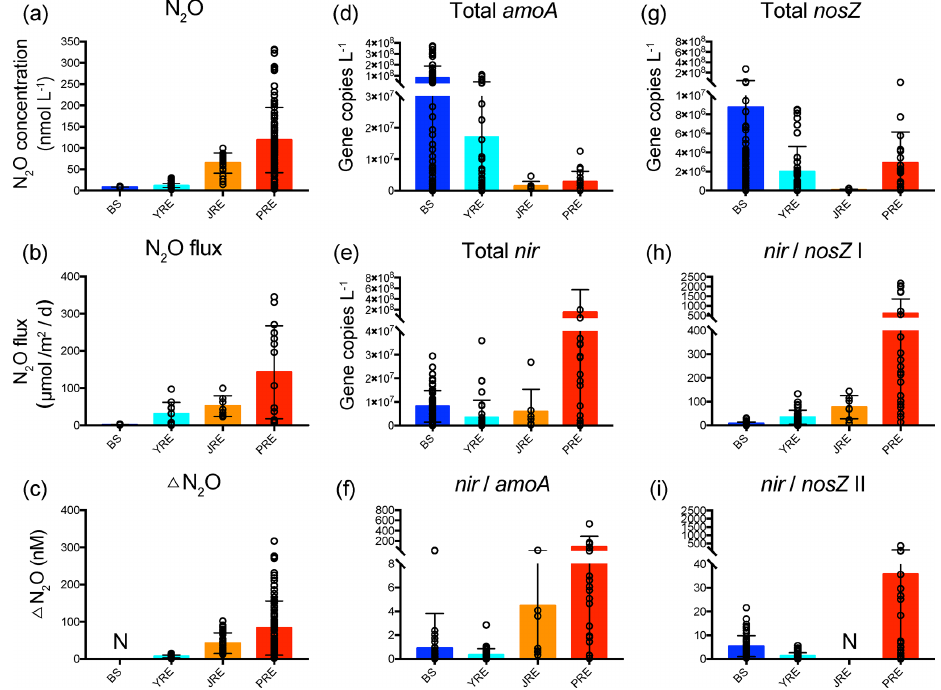
Figure 6. The ranges of (a) N 2 O concentration; (b) N 2 O flux; (c) (cid:49) N 2 O (data from Chen et al., 2008; Lin et al., 2016, 2020; Ma et al., 2019; Song et al., 2015; Wang et al., 2014, 2016; Wu et al., 2013; Xu et al., 2005; Zhan et al., 2011; Zhang et al., 2008, 2010); (d) total archaeal and bacterial amoA gene abundance; (e) total nirS and nirK gene abundance; (f) the ratio of total nir to amoA gene abundance; (g) total nosZ clade I and II gene abundance; (h) the ratio of total nir to nosZ clade I gene abundance; and (i) ratio of total nir to nosZ clade II gene abundance in the Bohai Sea (BS), Yangtze River estuary (YRE), Jiulong River estuary (JRE), and Pearl River estuary (PRE). Black circles represent the value of each sample. Bars represent the mean values. Error bars indicate standard deviation. N: no data or not